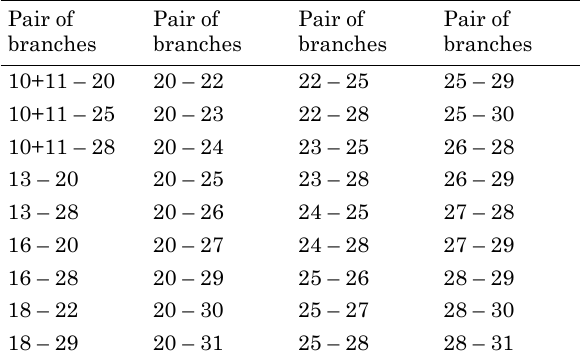
Table 5. Statistically significant differences between